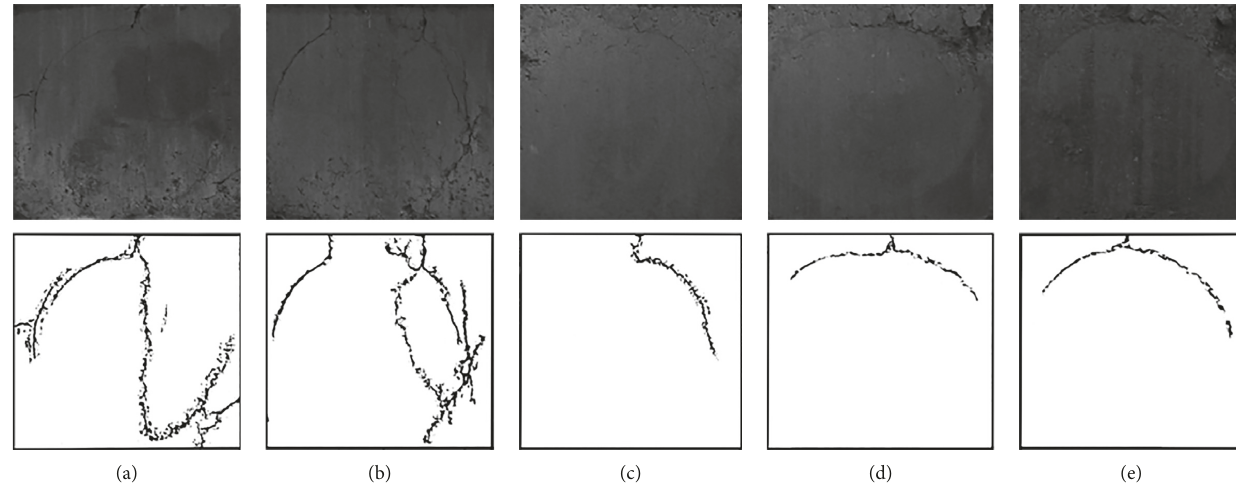
Figure 17: Crack propagation on coal surface. (a) q � 0MPa. (b) q � 1.127MPa. (c) q � 3.38MPa. (d) q � 3.943MPa. (e) q �